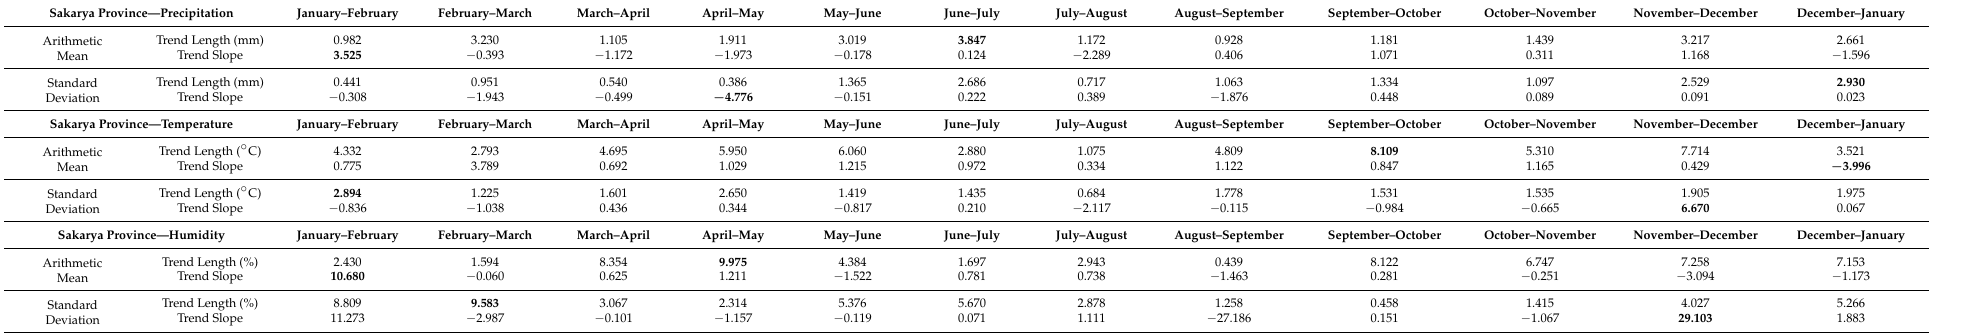
Table 6. Statistical Values of Arithmetic Mean and Standard Deviation of Sakarya